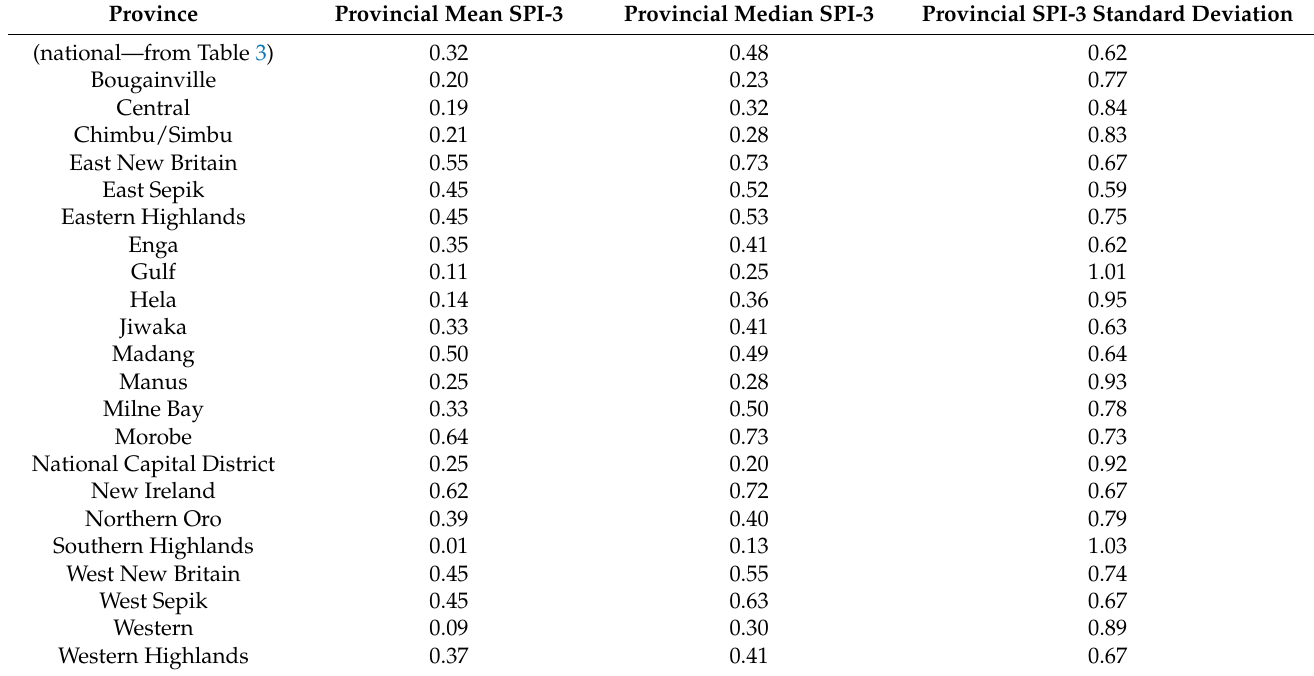
Table A1. Mean, median and standard deviation for provincially averaged SPI-3.